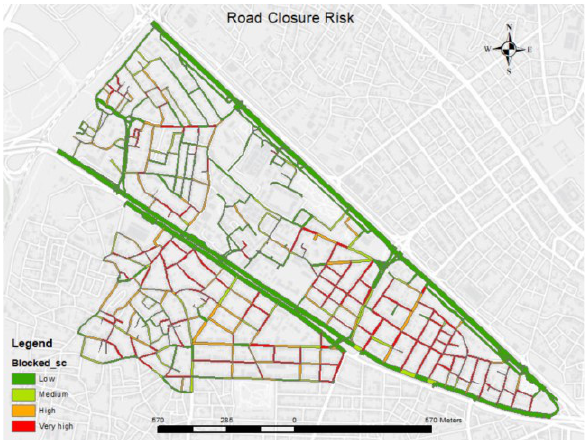
Figure 9 . Road closure risk. Source: de Vries,